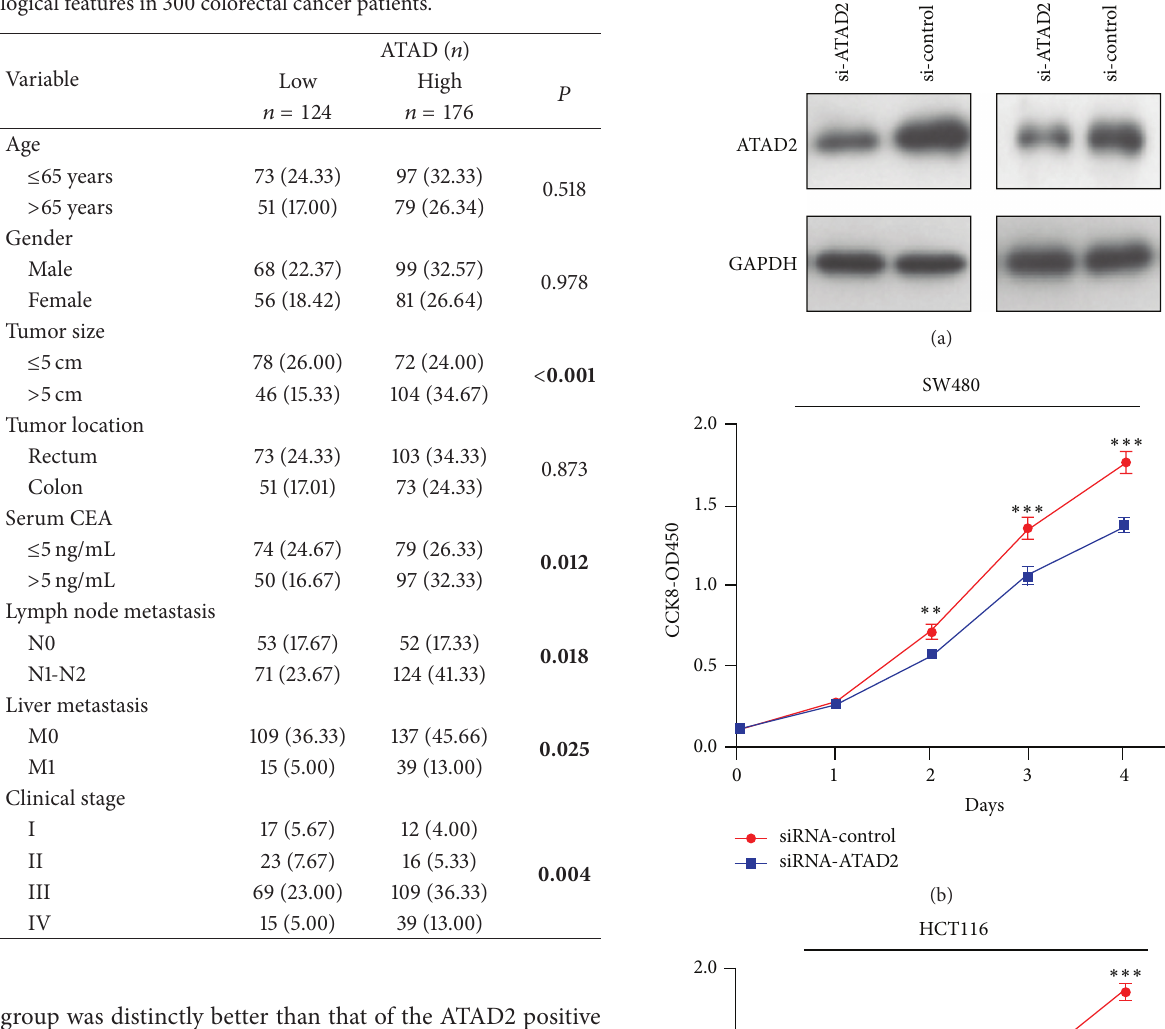
Table 1: Relationship between ATAD2 expression and clinicopatho- logical features in 300 colorectal cancer patients.